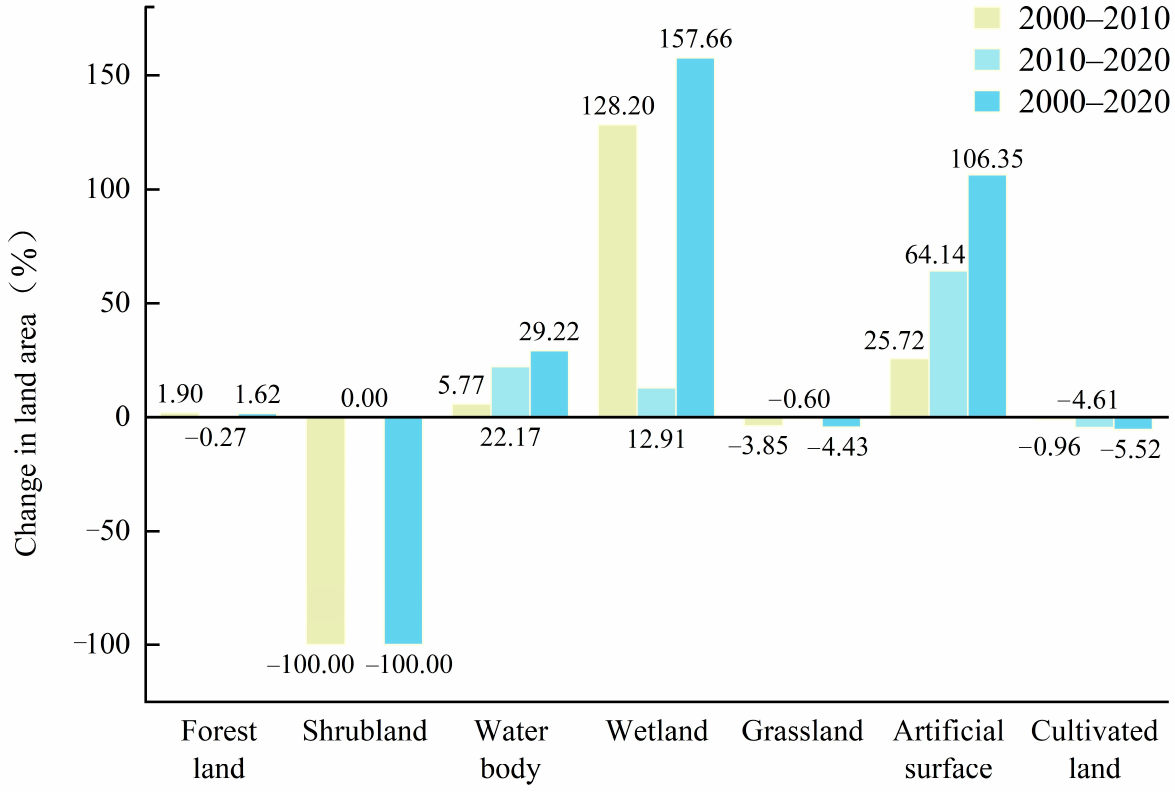
Figure 4. Land use and land cover (LULC) dynamics between 2000 and 2020 in Changzhi City.